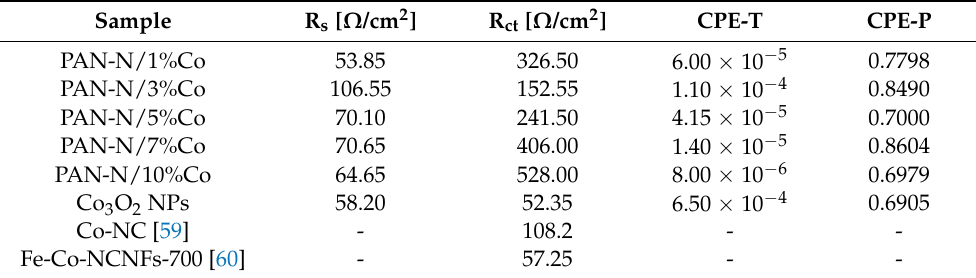
Table 3. Resulting data from the simulated equivalent circuit for the different Co-doped PAN-N samples and the reference Co 3 O 4 NPs. Data values reported for other Co@NC-based electrocatalysts are included.